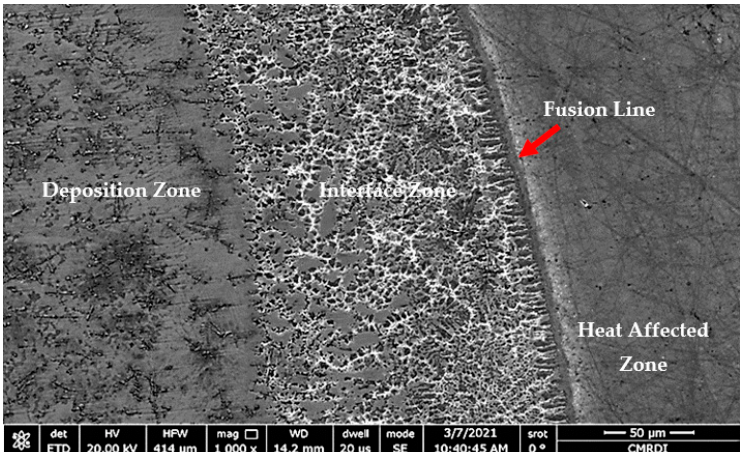
Figure 4. FESEM micrograph of S1 cross-section of the whole deposited layer showing three different zones: deposition, interface, and HAZ.